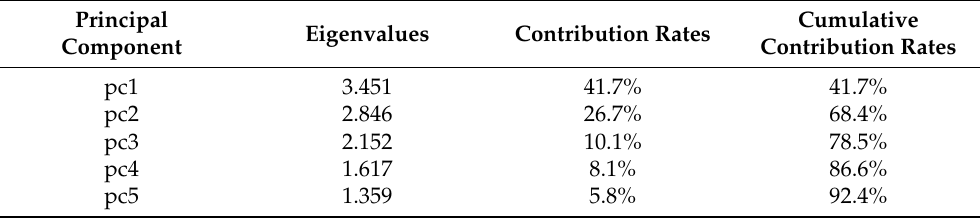
Table 3. The eigenvalues and cumulative contribution rates of each principal component.